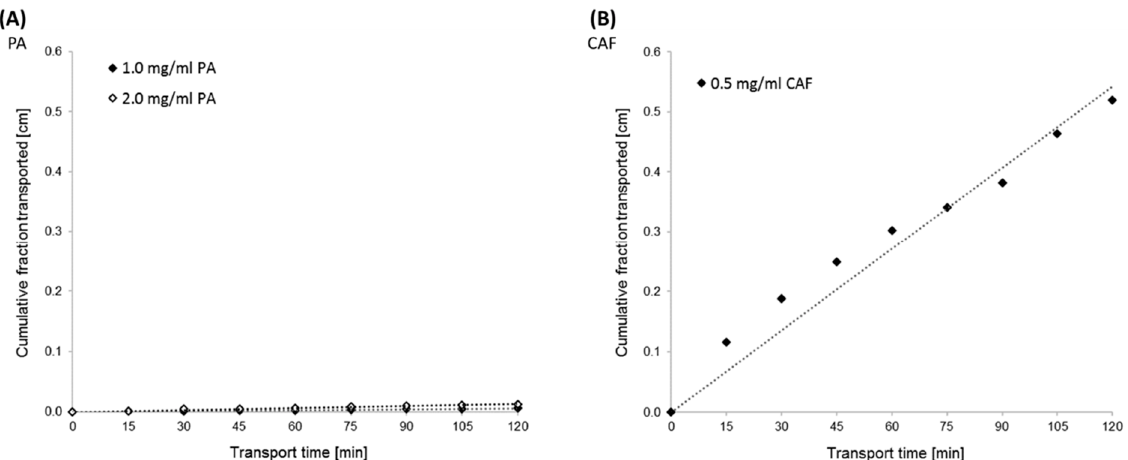
Figure 2. Change in the transepithelial electrical resistance (TEER) over time during Caco-2 cell culture on membranes directed towards the formation of the integral intestinal epithelium. Results of the three independent replicates are presented as the mean ± SD.